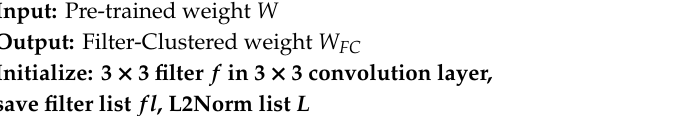
Algorithm 1. 8-bit filter clustering for convolutional layers consisting only of 3 × 3